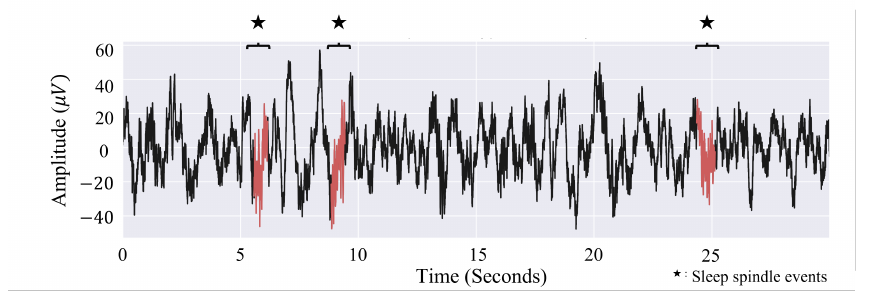
Figure 6. EEG spindle detected by YASA spindle detection algorithm. The red lines represent the detected